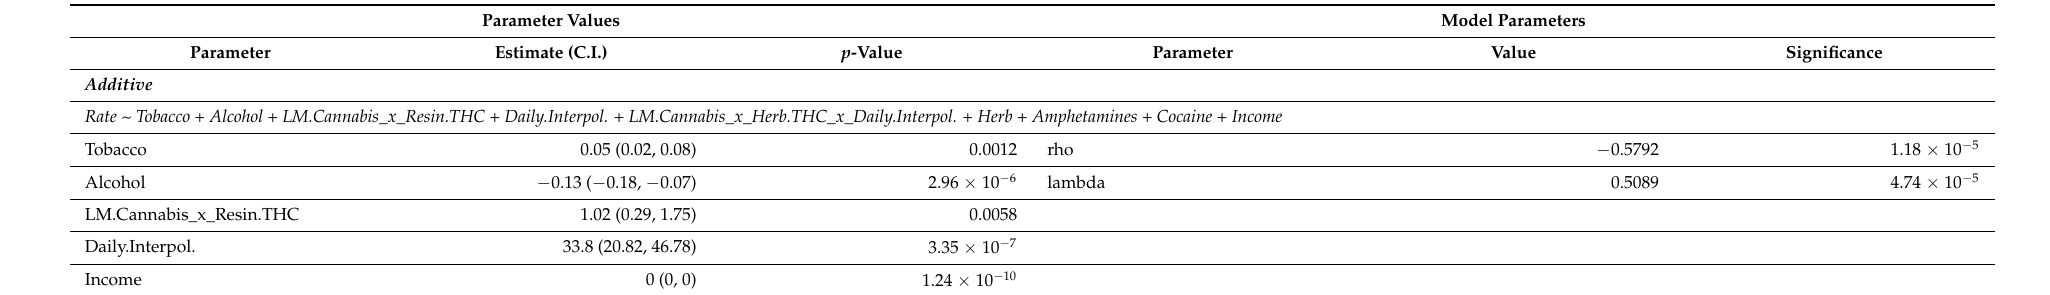
Table 5. Multivariate Geospatial Regression for Edwards Syndrome (Trisomy